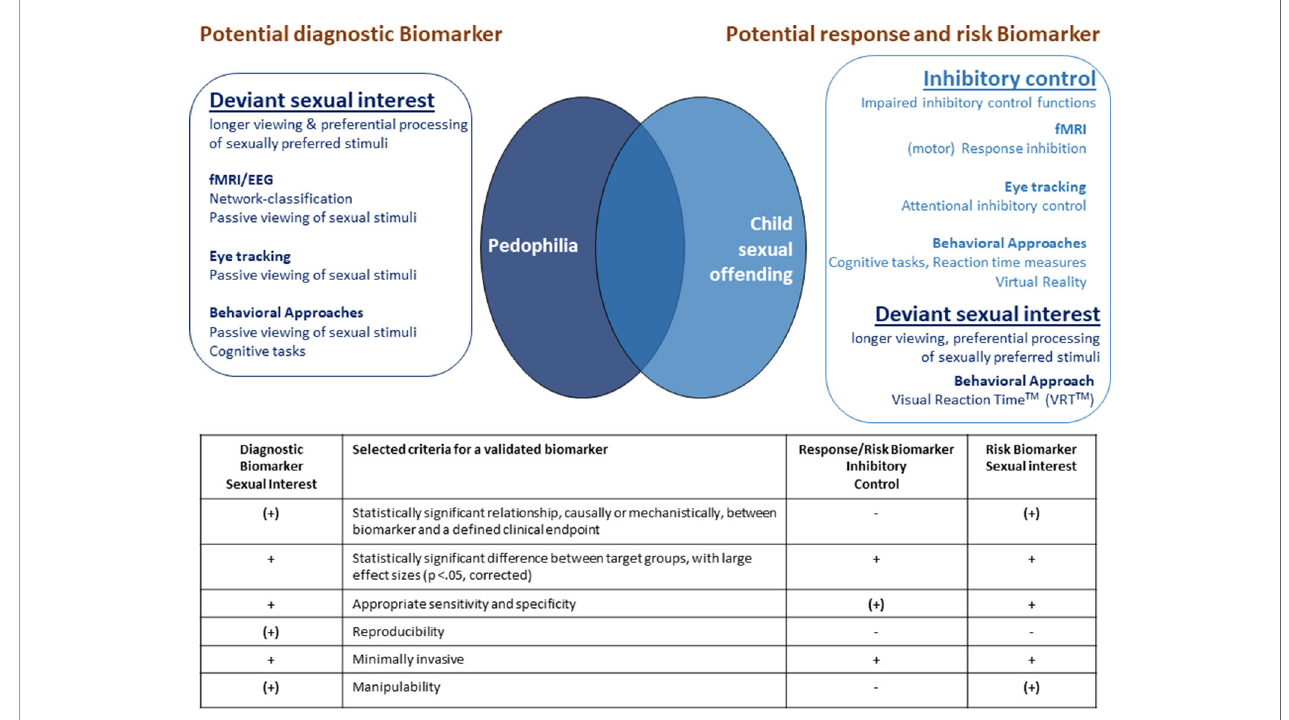
FIGURE 1 | Suggested potential composite diagnostic, response and risk biomarkers for pedophilia and child sexual offending. The table summarizes the evaluation of these potential biomarkers according to selected criteria for validated biomarkers. +: ful fi lls the criterion, (+): ful fi lls the criterion with restrictions, -: does not ful fi ll the